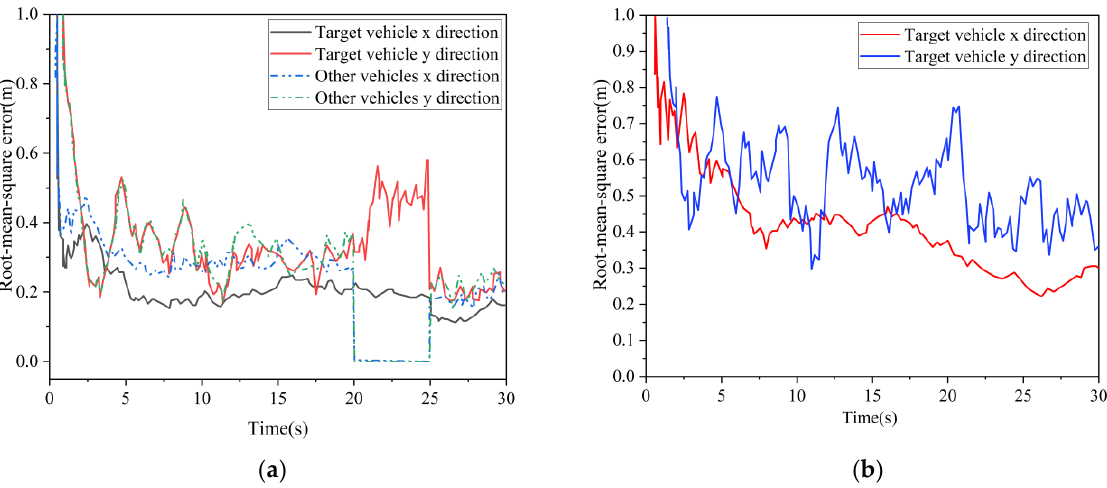
Figure 10. Error variation in a particular channel change simulation: ( a ) Multi-vehicle cooperative positioning error; ( b ) Individual vehicle positioning error.